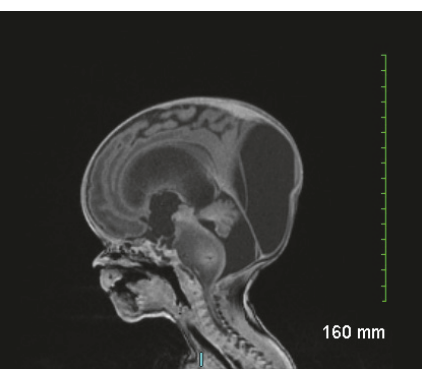
Figure 1: MRI showing an expansile, poorly demarcated mass in the pons with minimal heterogenous enhancement and severe communicating hydrocephalus.